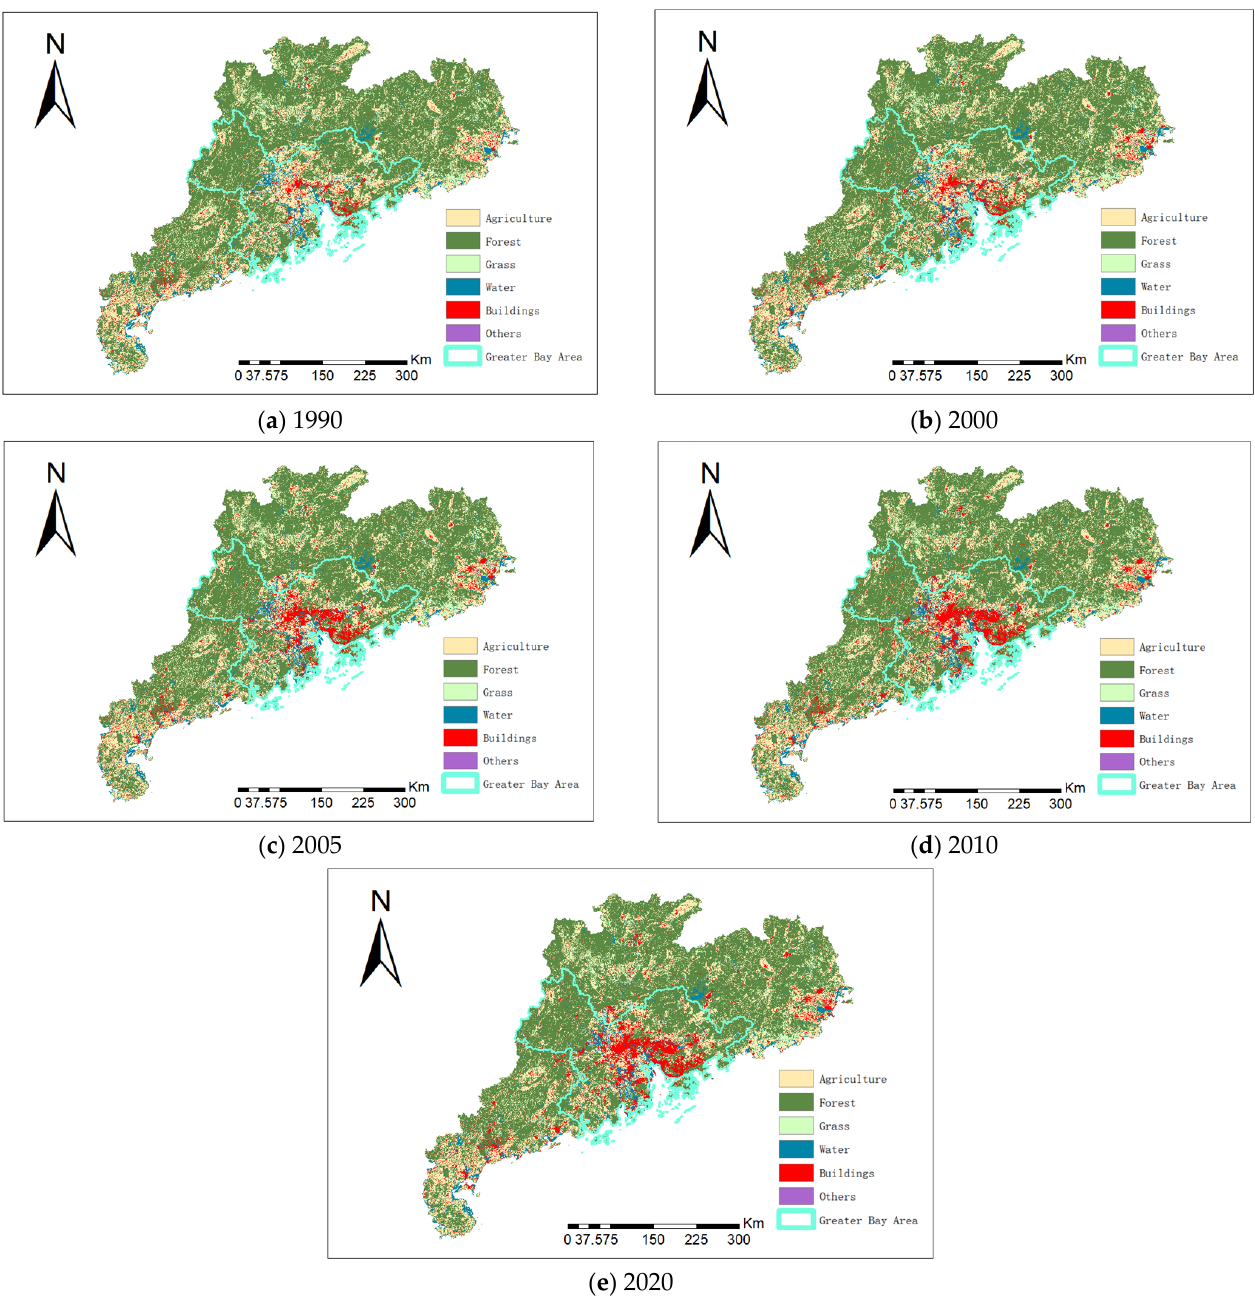
Figure 2. Multi-period land use/land cover remote sensing monitoring data.